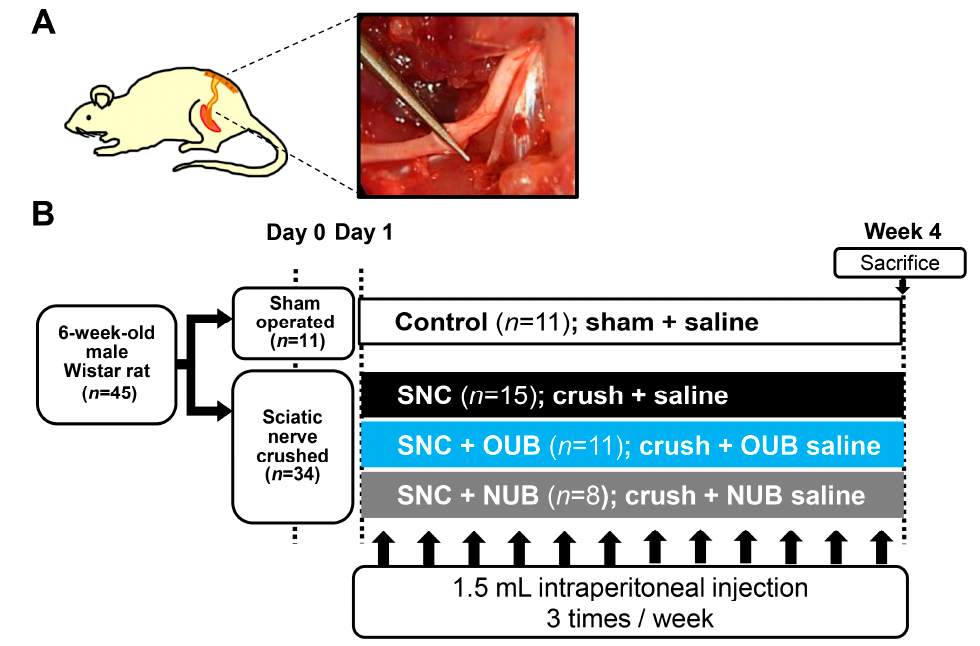
Figure 8. ( A ) Schematic diagram and photo of the surgical procedure. The sciatic nerve 5 mm distal from the sciatic notch was crushed three times in three different directions for 10 s per crush; ( B ) experimental protocols. SNC: sciatic nerve crush injury, OUBs: oxygen ultra-fine bubbles, and NUB: nitrogen ultra-fine bubble.